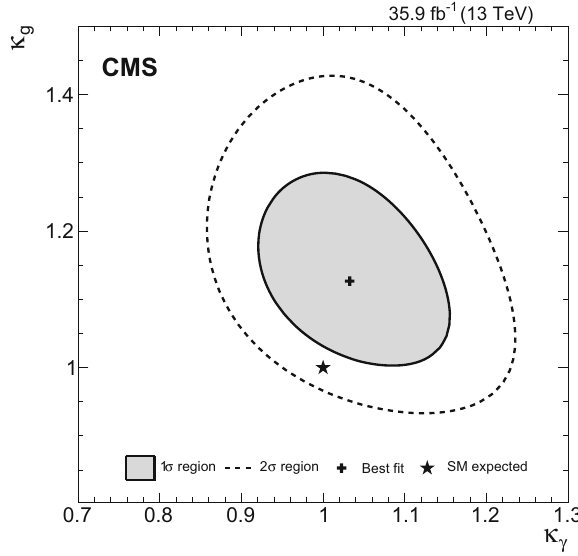
H assuming σ and 2 σ CL regions in the κ κ γ parameter H g vs.